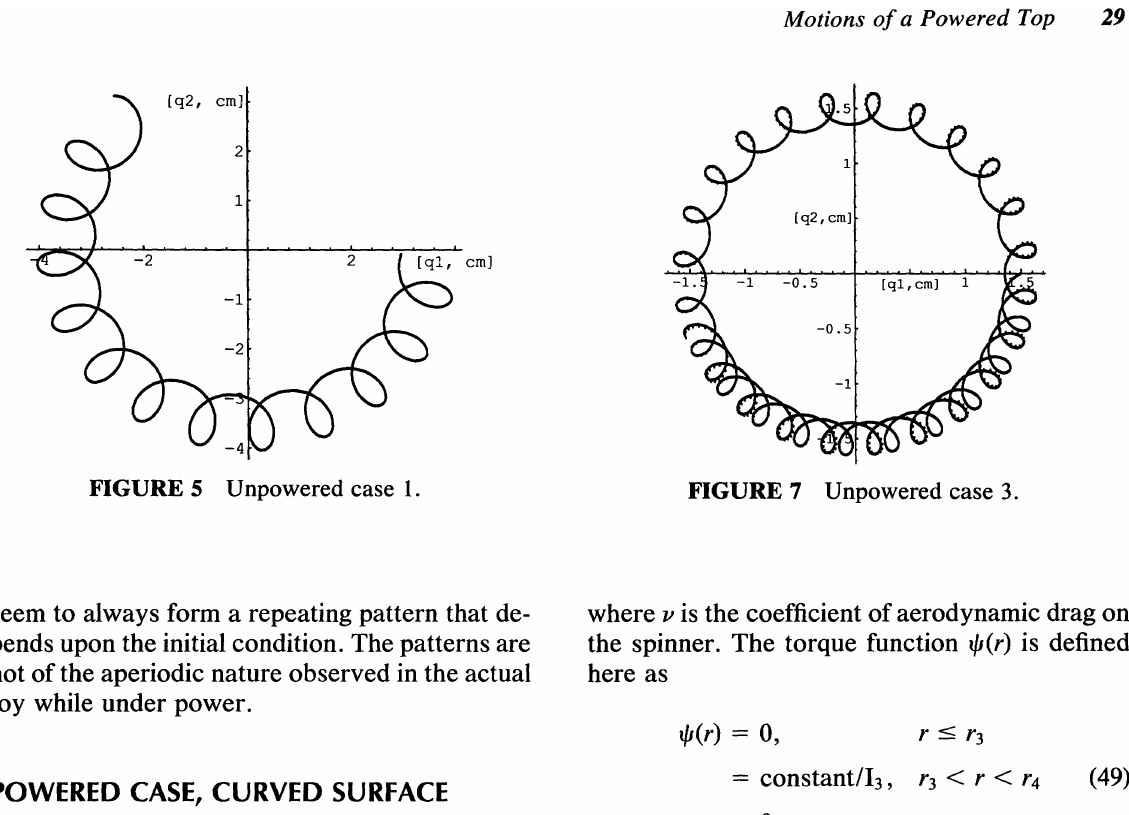
FIGURE 5 Unpowered case 1.